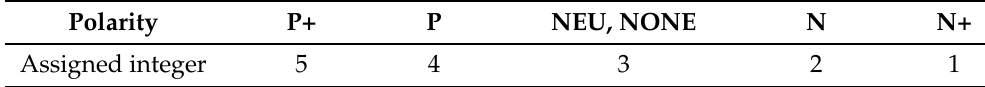
Table 5. Integer number assigned to each type of polarity.